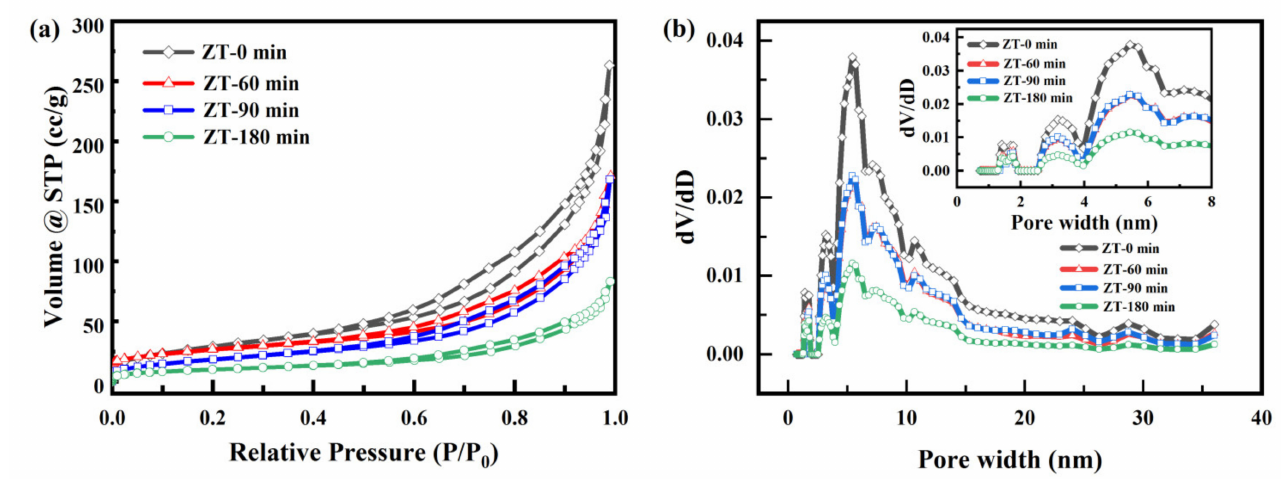
Figure 6. N 2 adsorption/desorption isotherms ( a ) and pore size distribution ( b ) of Z100T200 at different catalytic